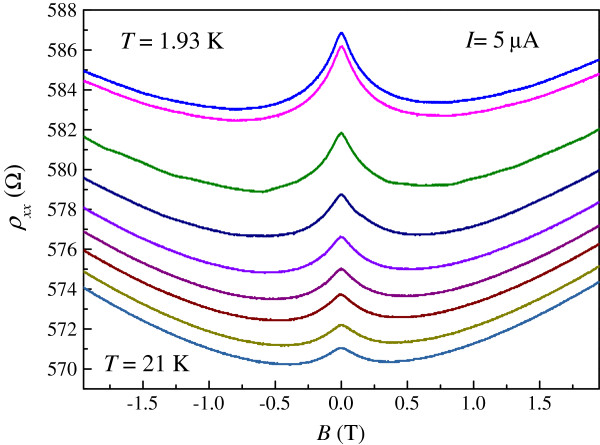
The magnetoresistivity measurements ρxx (B) at different temperatures T. From top to bottom: T = 1.93, 1.98, 4, 6, 8, 10, 12, 15, 18, and 21 K.